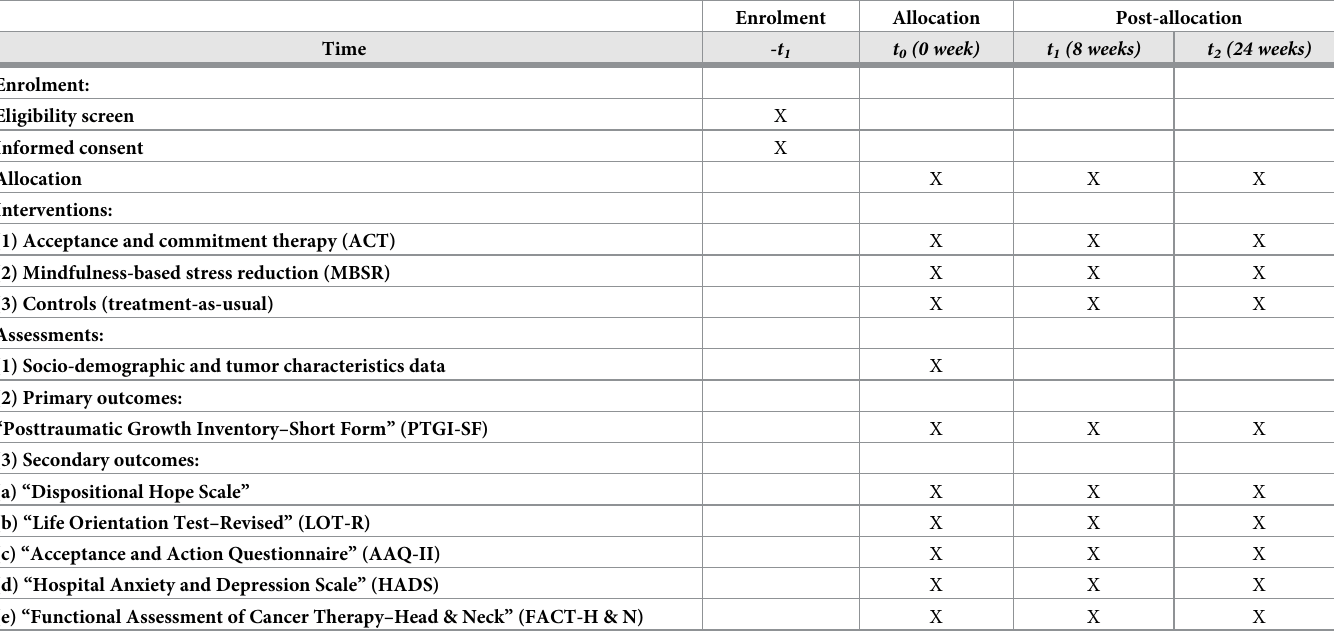
Table 1. Scheduled assessment of the randomized control trial’s outcome